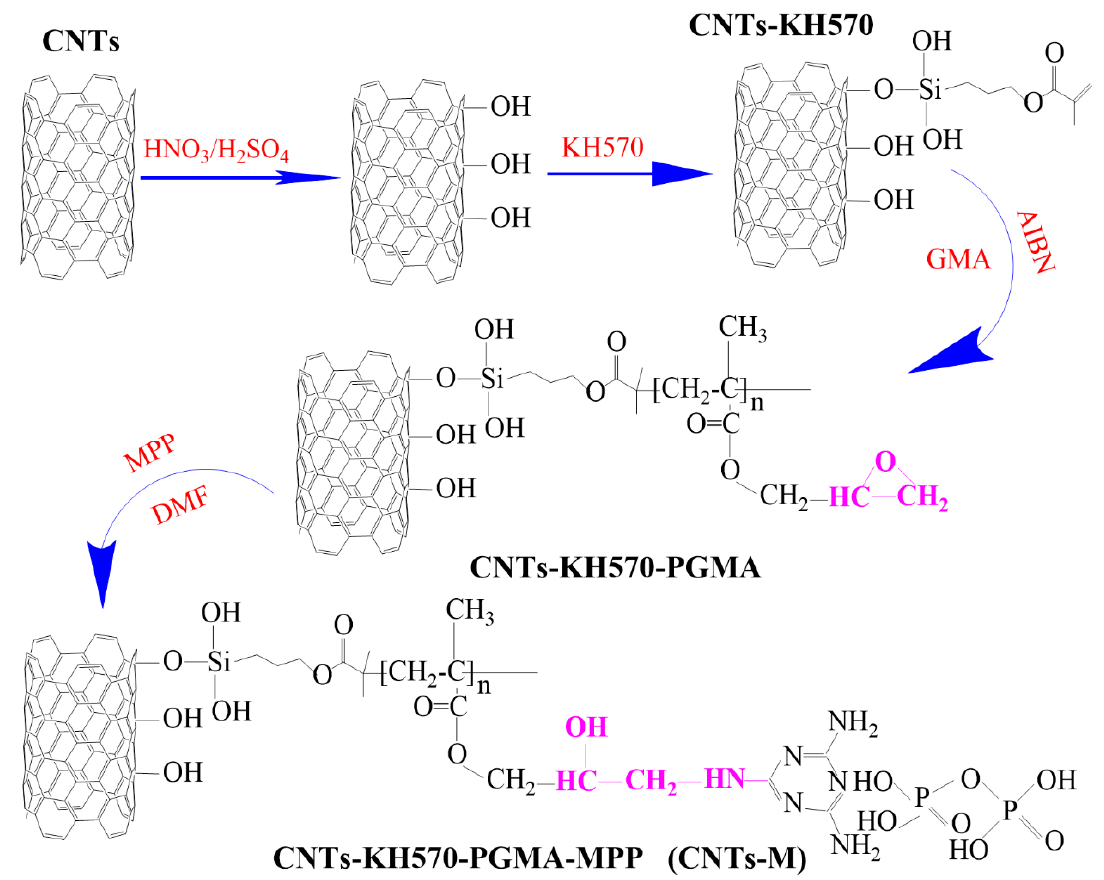
Figure 1. Schematic diagram of the preparation process of CNTs and their modified particles.